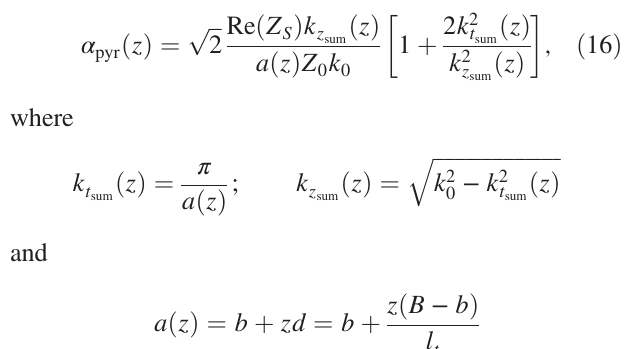
¼ 3 . 5 × 10 5 S = m. coat